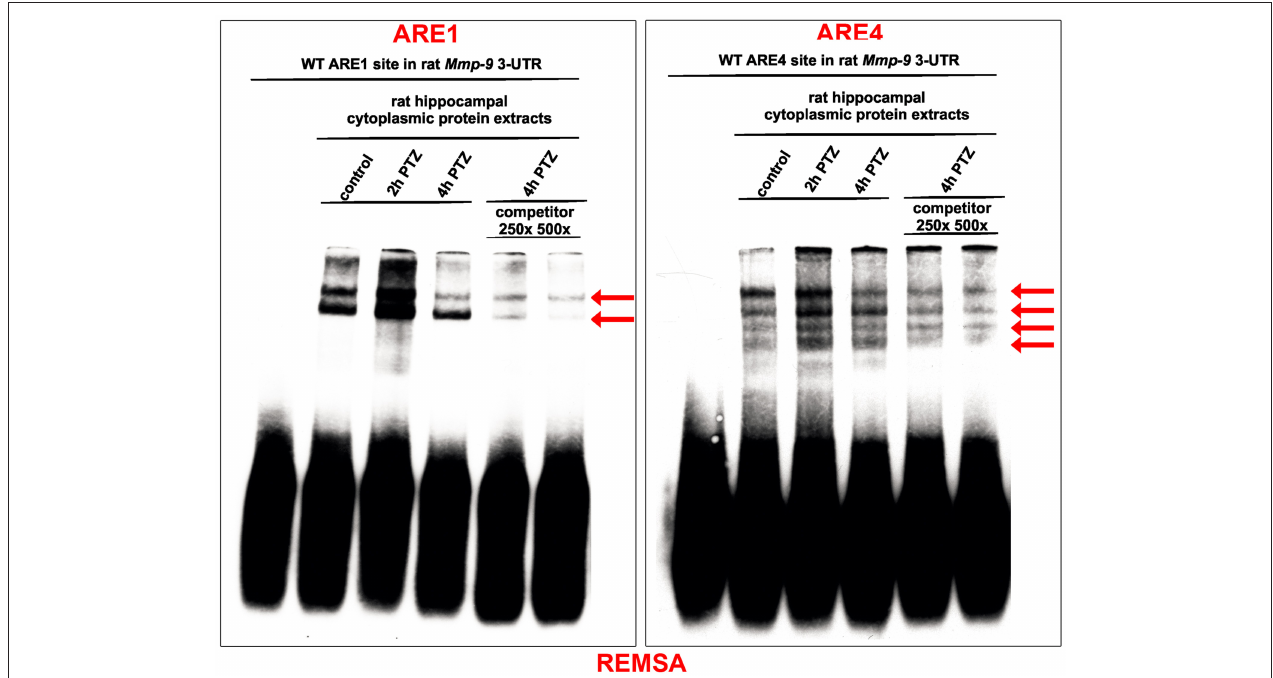
FIGURE 2 | Hippocampal cytoplasmic protein complexes bind in vitro to ARE1 and ARE4 motifs of the Mmp-9 mRNA 3 ′ UTR, and these interactions are increased in response to PTZ-evoked neuronal activation. The protein–RNA interactions were analyzed by REMSA. Biotynylated RNA probes derived from ARE1 or ARE4 sites of the rat Mmp-9 mRNA 3 ′ UTR were incubated with equal amounts of cytoplasmic protein lysates isolated from the unstimulated as well as PTZ-stimulated (2 and 4h after PTZ-induced seizures) rat hippocampi. Additionally, as a control of binding specificity, we included samples obtained by the incubation of cytoplasmic extracts collected from the PTZ-treated (4h after PTZ) rat hippocampi with biotynylated RNA probes derived from ARE1 or ARE4 sites of the rat Mmp-9 mRNA 3 ′ UTR and mixed with 250 × or 500 × excess of competitors (the corresponding unlabeled ARE probes). The specifically shifted bands are marked by arrows. Representative images are